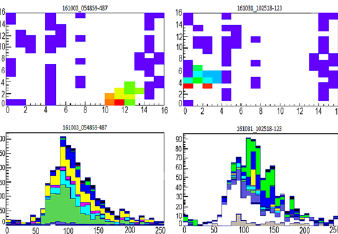
Figure 2. Left: Instant track-like flashes’ waveforms of ten PMTs with the highest amplitudes. Right: the waveforms of slow-flashes Figure 3. The EAS candidates. Upper plots – image of event with hit pixels and not-working (blue) ones. Bottom plots – the amplitude variation of time for selected hit